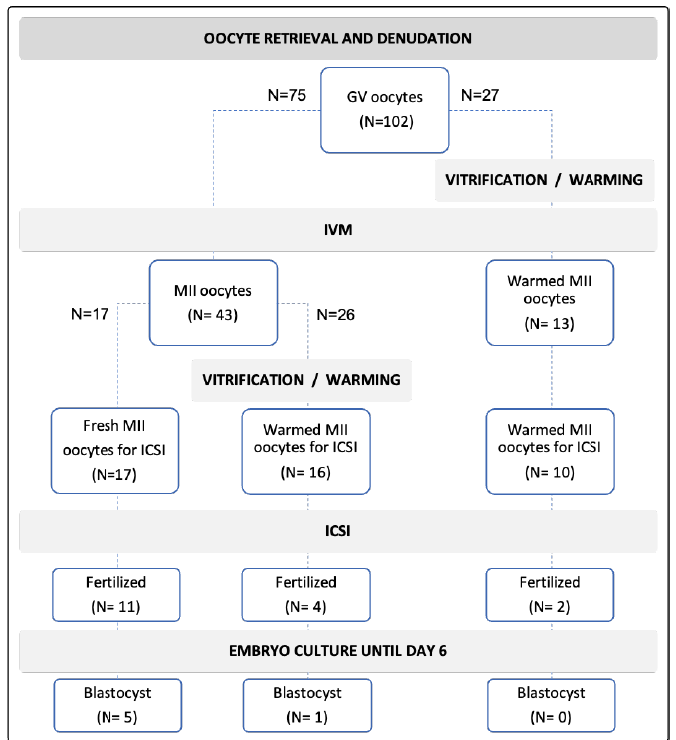
Figure 1. Overview of oocyte distribution along different processes of rIVM, vitrification and warm- ing, and ICSI and embryo development.